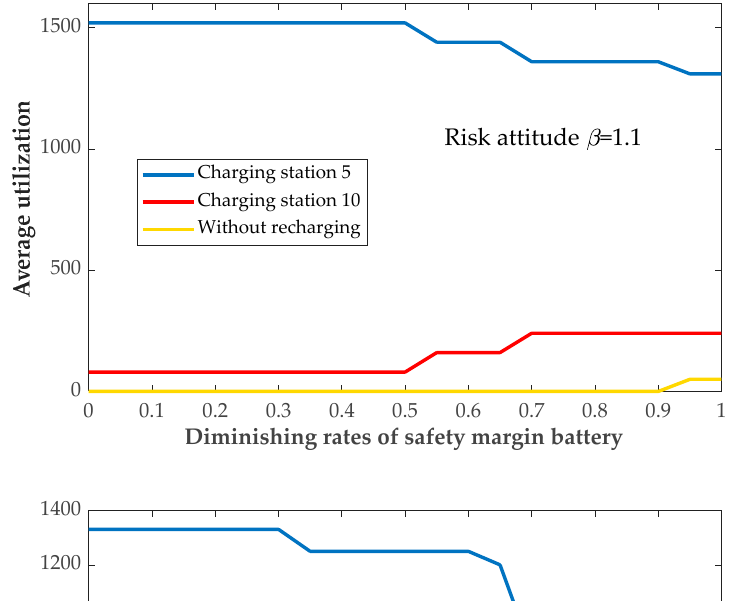
Figure 4. Recharging time information.